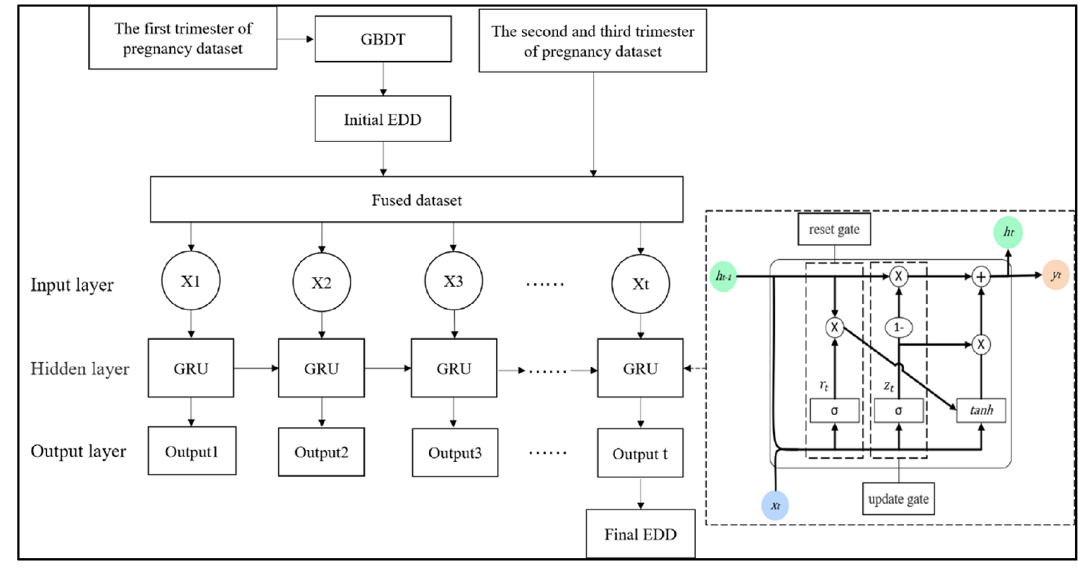
Figure 3. Structure of